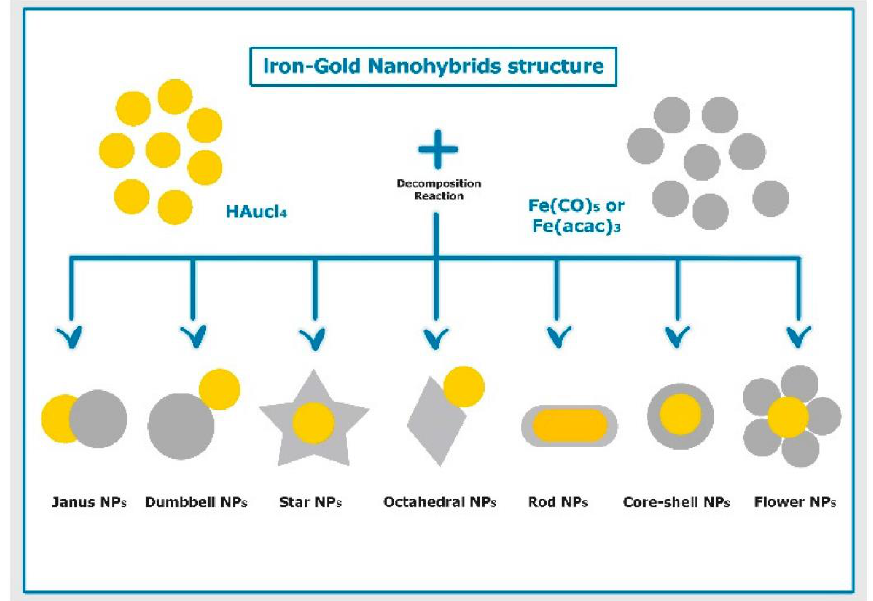
Figure 5. Schematic illustration of different structures of iron–gold hybrid nanoparticles prepared using thermal decomposition method. Reproduced from [125], MDPI, 2021.